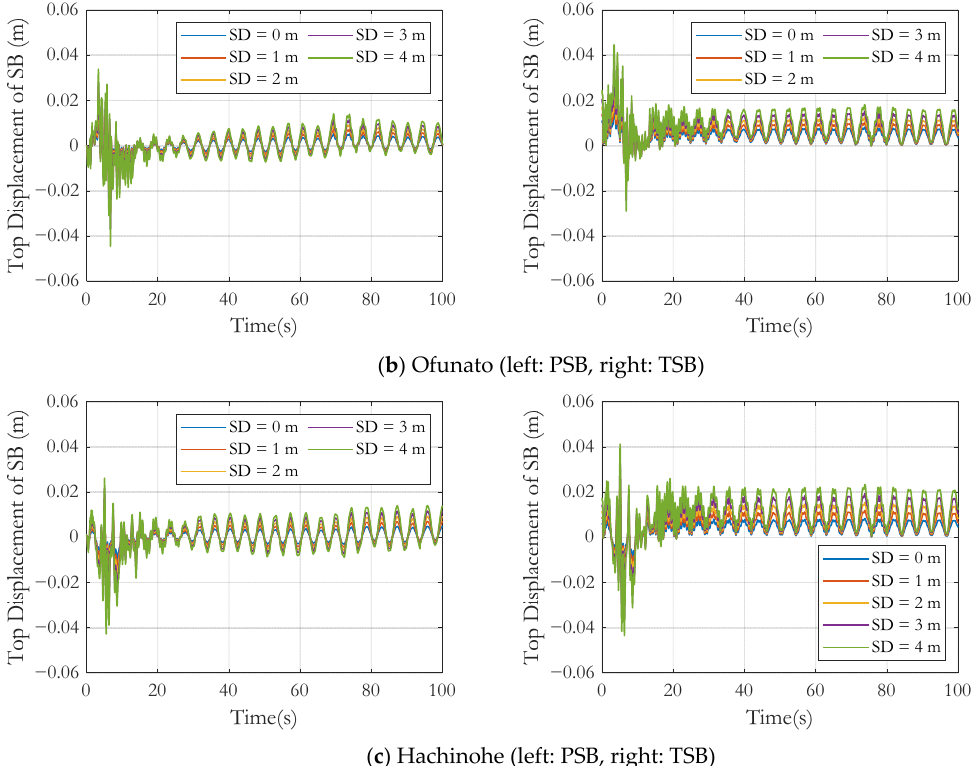
Energies 2022 , 15 , x FOR PEER REVIEW